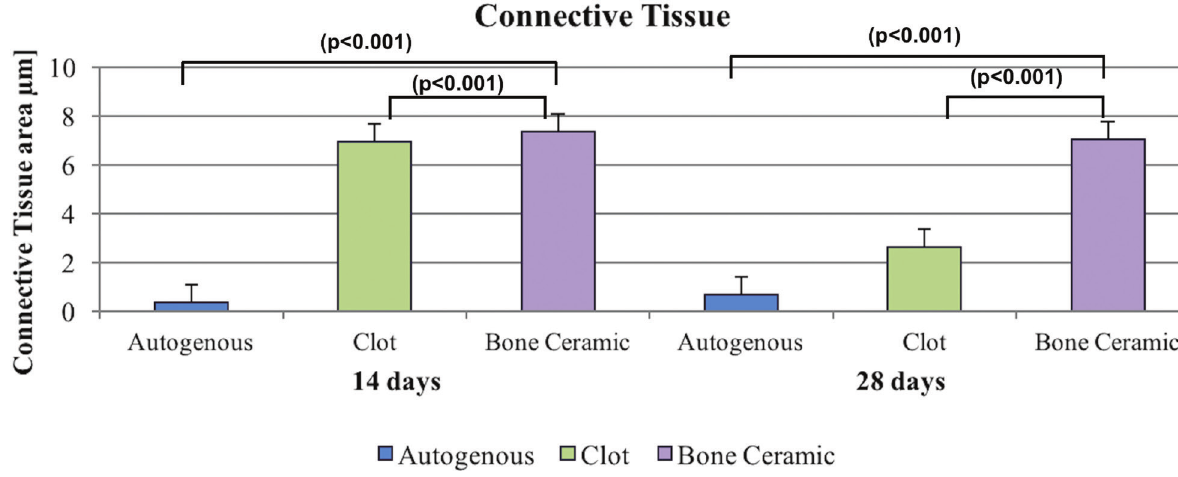
Figure 4- Neoformed connective tissue at 14 and 28 days